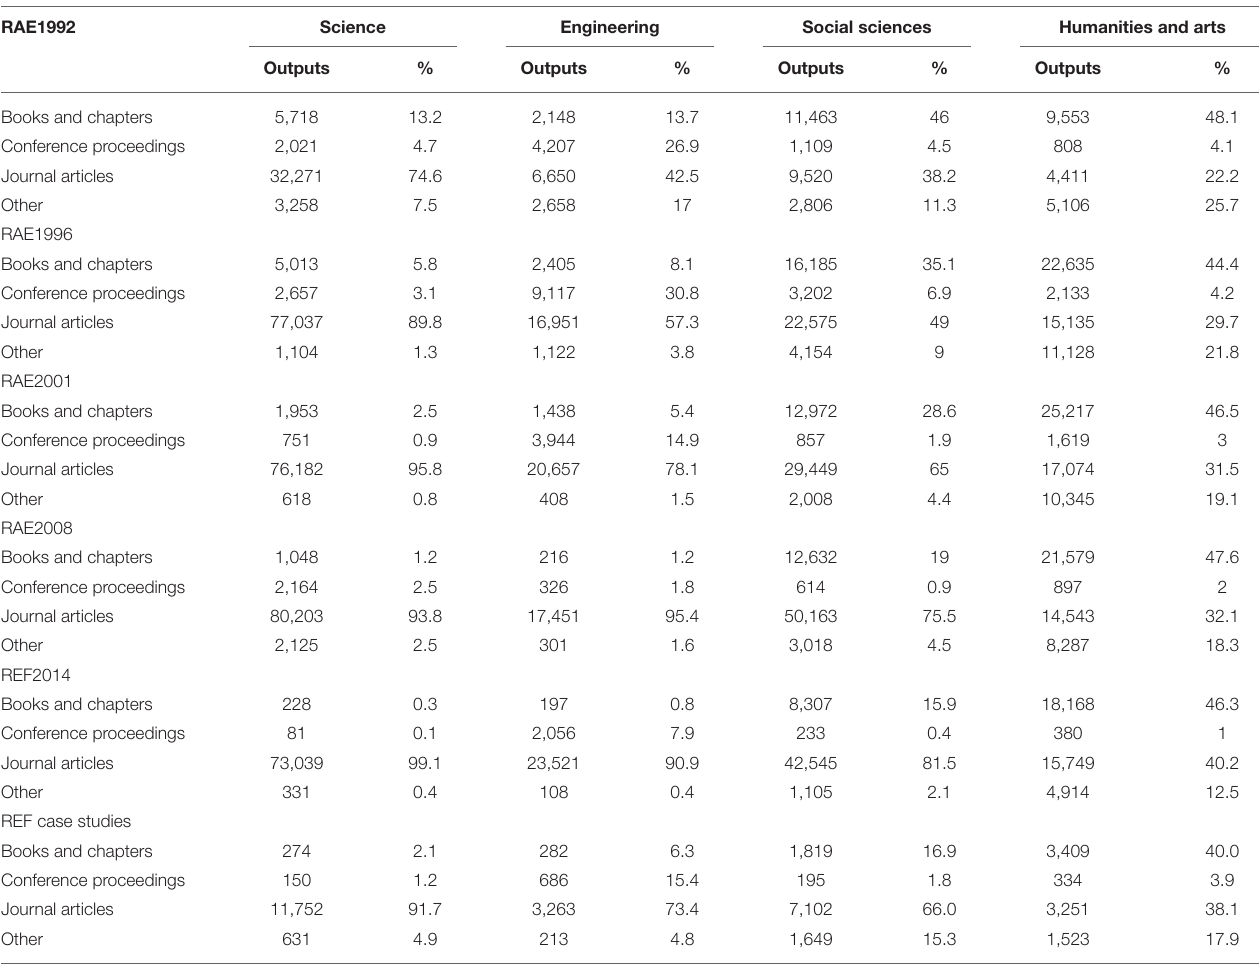
TABLE 2 | Relative frequency of types of submitted output across successive cycles of the UK Research Assessment Exercise (1992–2008) and Research Excellence Framework (2014).